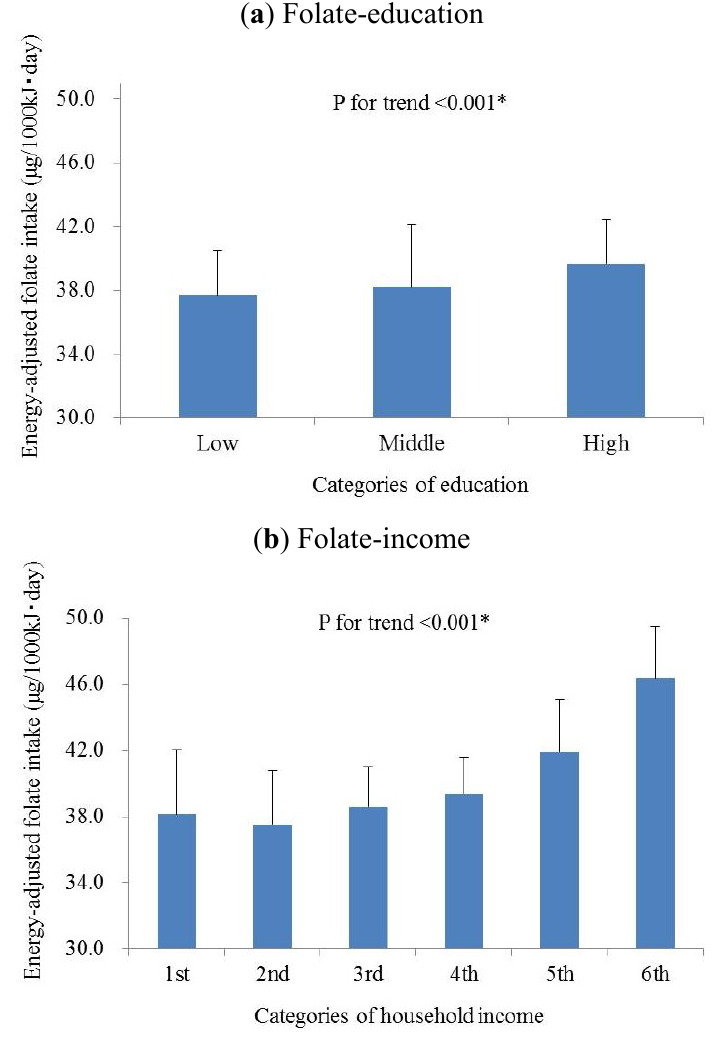
Figure 1. The associations of ( a ) education levels classified by the International Standard Classification of Education (ISCED) and ( b ) household incomes with folate intake